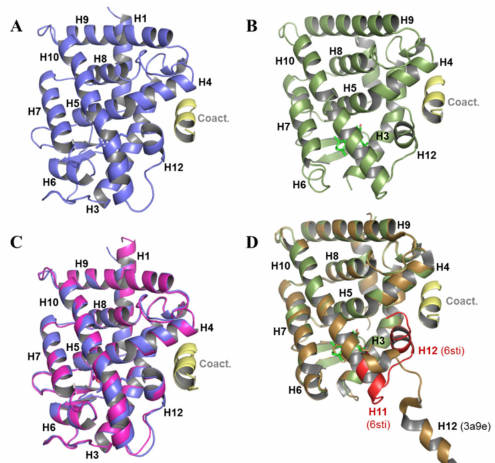
Figure 7. 3D crystal structure of RAR β and RXR α LBDs in complex with LG754 and a coactivator peptides. ( A ) cartoon representation of RAR β LBD. Helices are numbered from H1 to H12, the latest being the activation helix that adopts the agonist conformation. The coactivator peptide (SCR1 NR2) bound to the surface formed by H3, H4, and H12 of RAR β is shown in yellow. The ligand LG754 is shown by stick representation; ( B ) cartoon representation of RXR α LBD. The coactivator peptide (TIF2 NR2) bound to the protein is shown in yellow; ( C ) superposition of the two complexes of RAR β LBD bound to LG754 and coactivator peptide observed in the asymmetric unit; ( D ) superposition of our complex of RXR α LBD bound to LG754 and coactivator peptide (same as in B) with the crystal structure of RXR α LBD bound to LG754 in the context of the heterodimer RAR α -RXR α [69] (PDB code 3a9e). In the latest structure, the activation helix H12 adopts an antagonist position protruding outside the LBD, whereas, in the present structure (PDB code 6sti), helix H12 (shown in red) folds back on the LBD in the agonist position.